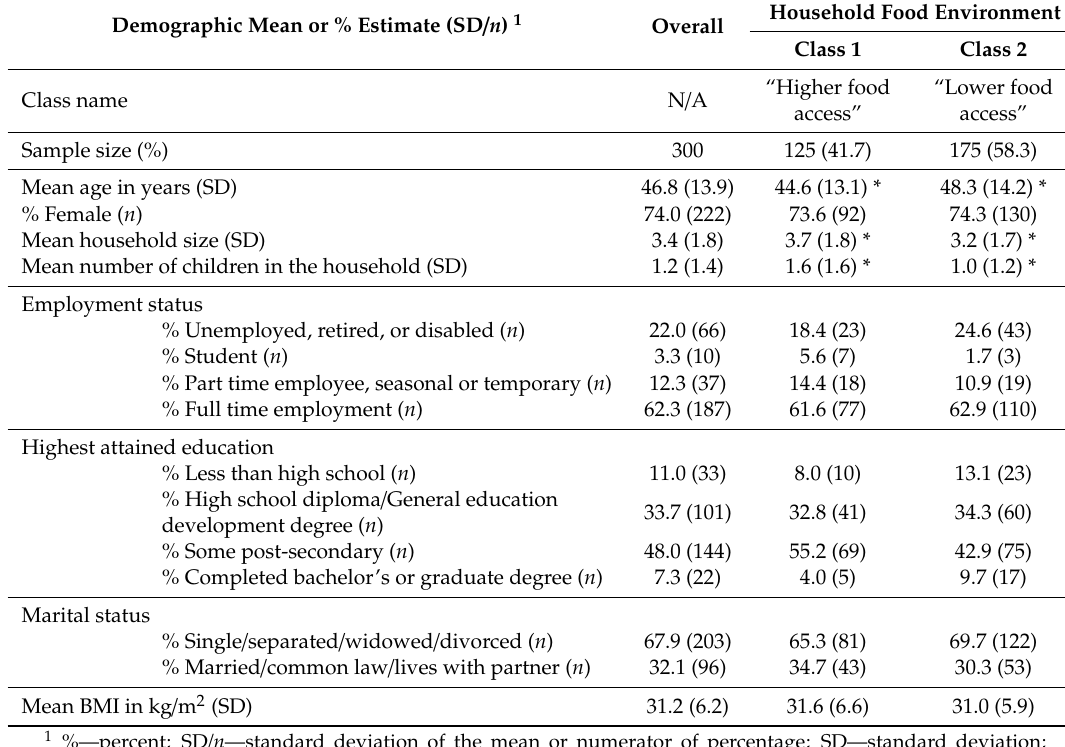
Table 3. Comparing demographic characteristics of two household food environment